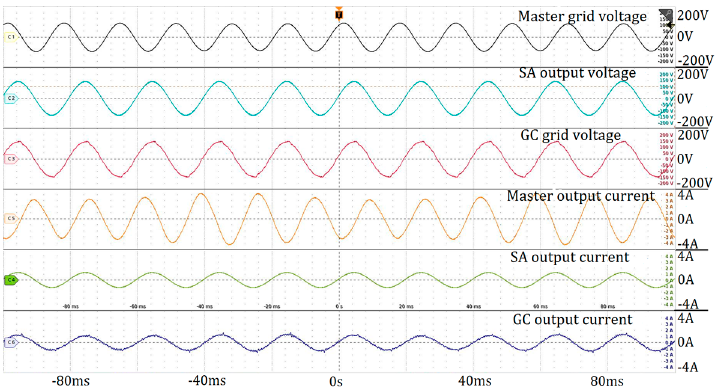
Figure 14. Voltage and current responses of the inverters in a back-to-back system. Abbreviations are: Stand-alone (SA), grid-connected (GC).